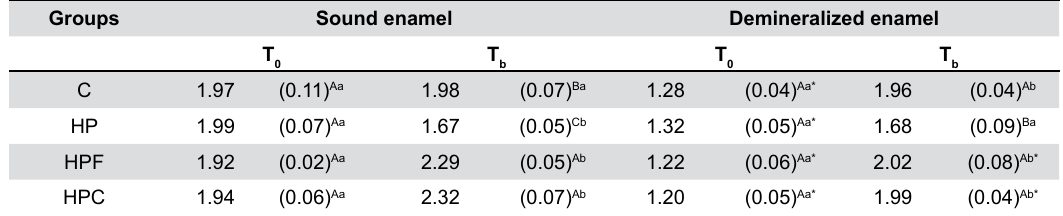
Table 4- Mean values and standard deviations of sound and demineralized enamel Ca/P weight ratios at baseline (T (T